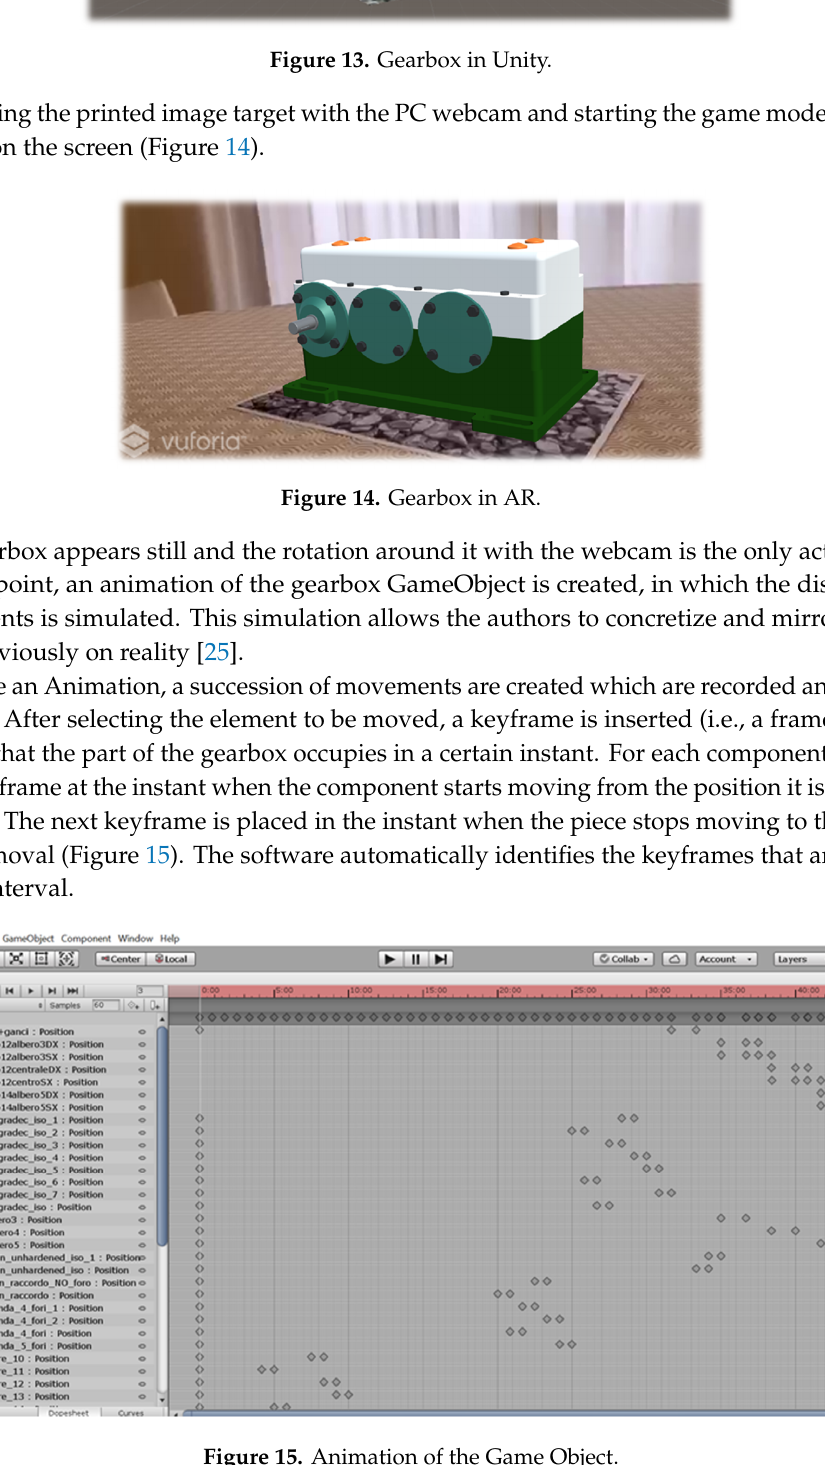
Figure 16. Animation of the Gearbox in AR. Figure 17. Virtual Button in AR. When the webcam is started, the gearbox will appear above the marker and the VirtualButton will also appear. As soon as the author’s hand is placed between ImageTarget and VirtualButton, the animation will start.